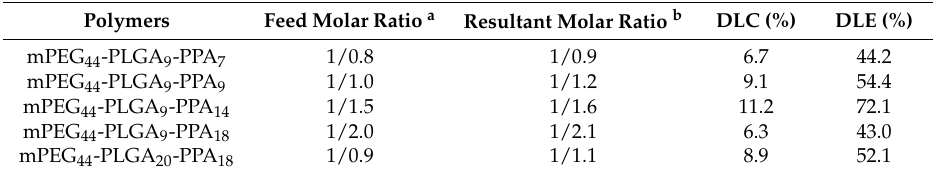
Table 4. Drug loading profiles of mPEG-PLGA-PPA copolymers with different block ratios.